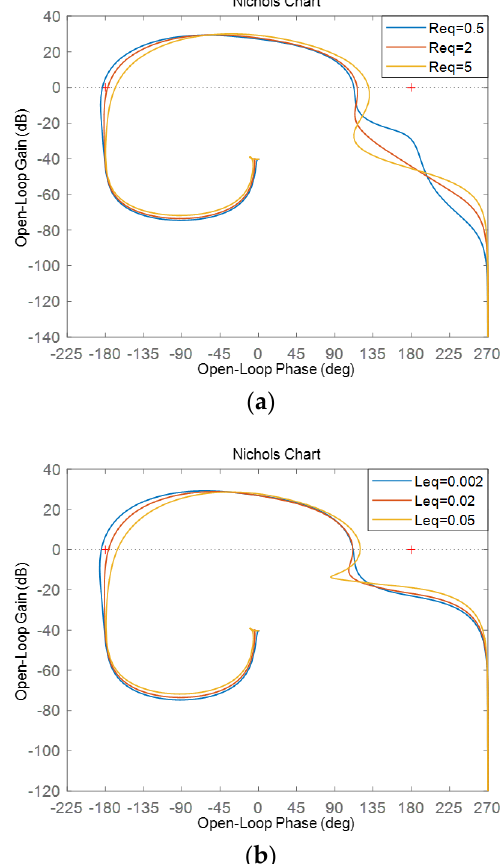
Figure 10. Nichols plots of T m under different equivalent virtual impedance values ( a ) R eq ; ( b ) L eq.